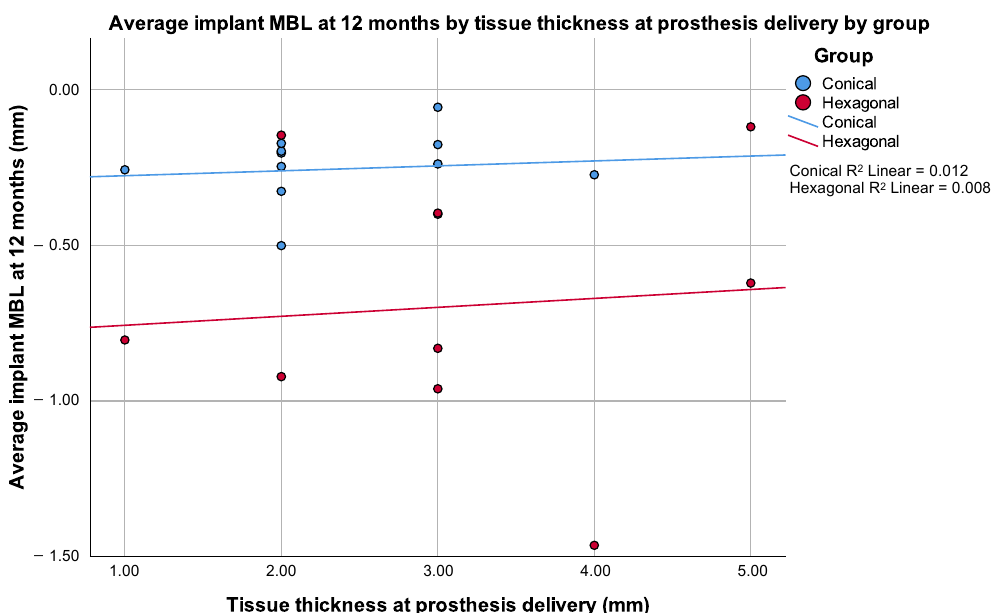
Figure 6. Scattered plot by group of the average implant MBL at 12 months by tissue thickness at prosthesis delivery. Note that Spearman’s rho correlation coefficient was 0.088 ( p = 0.787) for the conical group and 0.120 ( p = 0.759) for the hexagonal group.